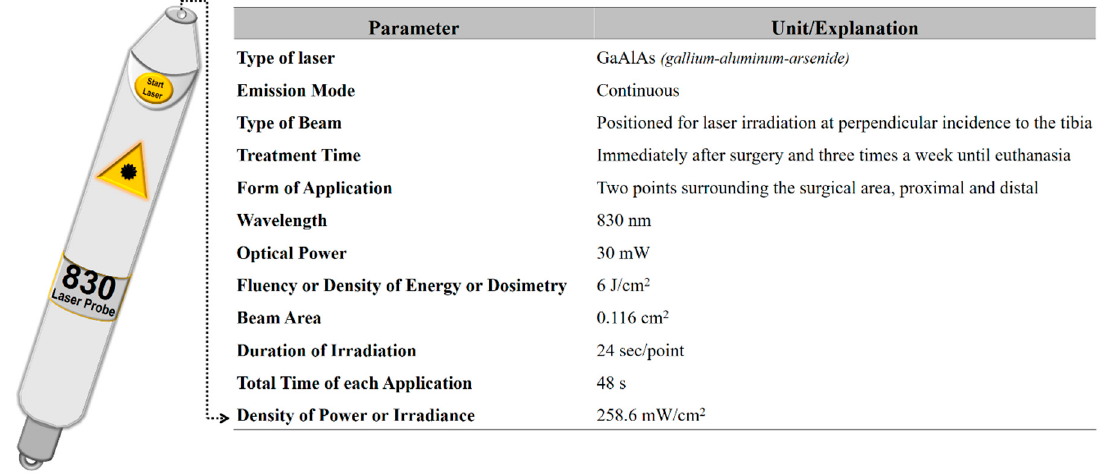
Figure 2. Details of the parameters used for PBMT application.